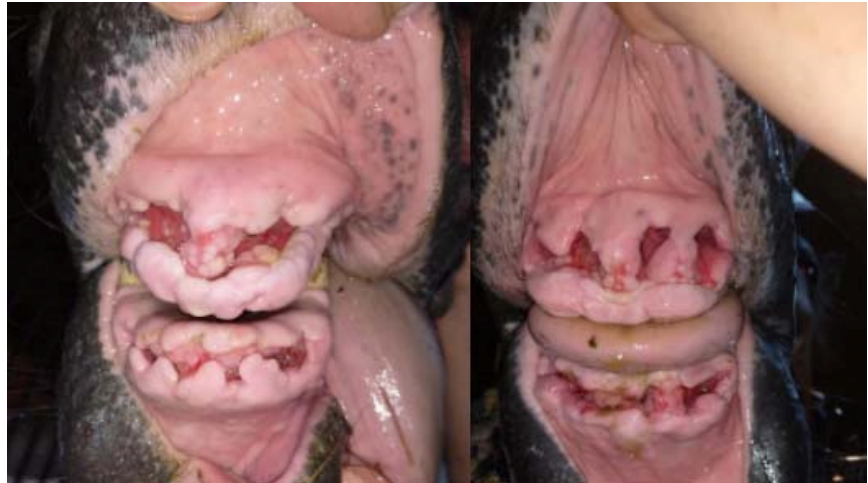
Figure 14. The condition of the teeth pockets 15 days after the procedure (on the left—case 1, on the right—case 2).